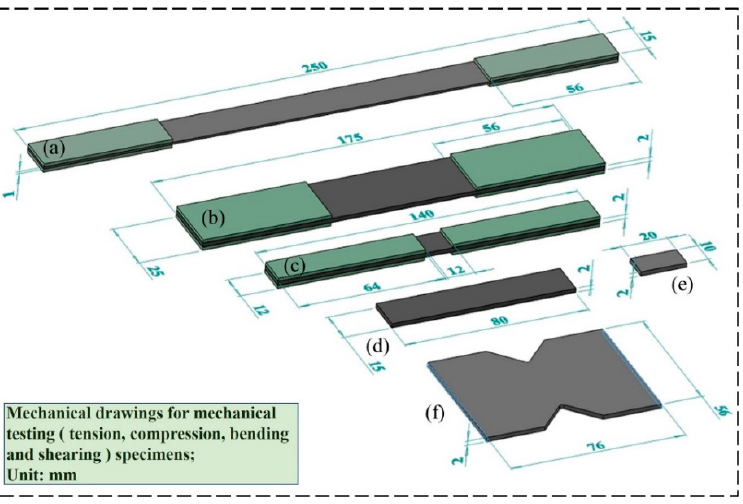
Figure 5. ( a ) 0° tensile specimen; ( b ) 90° tensile specimen; ( c ) 0° compression specimen; ( d ) bending specimen; ( e ) interlaminar shear specimen; ( f ) V-notched rail shear